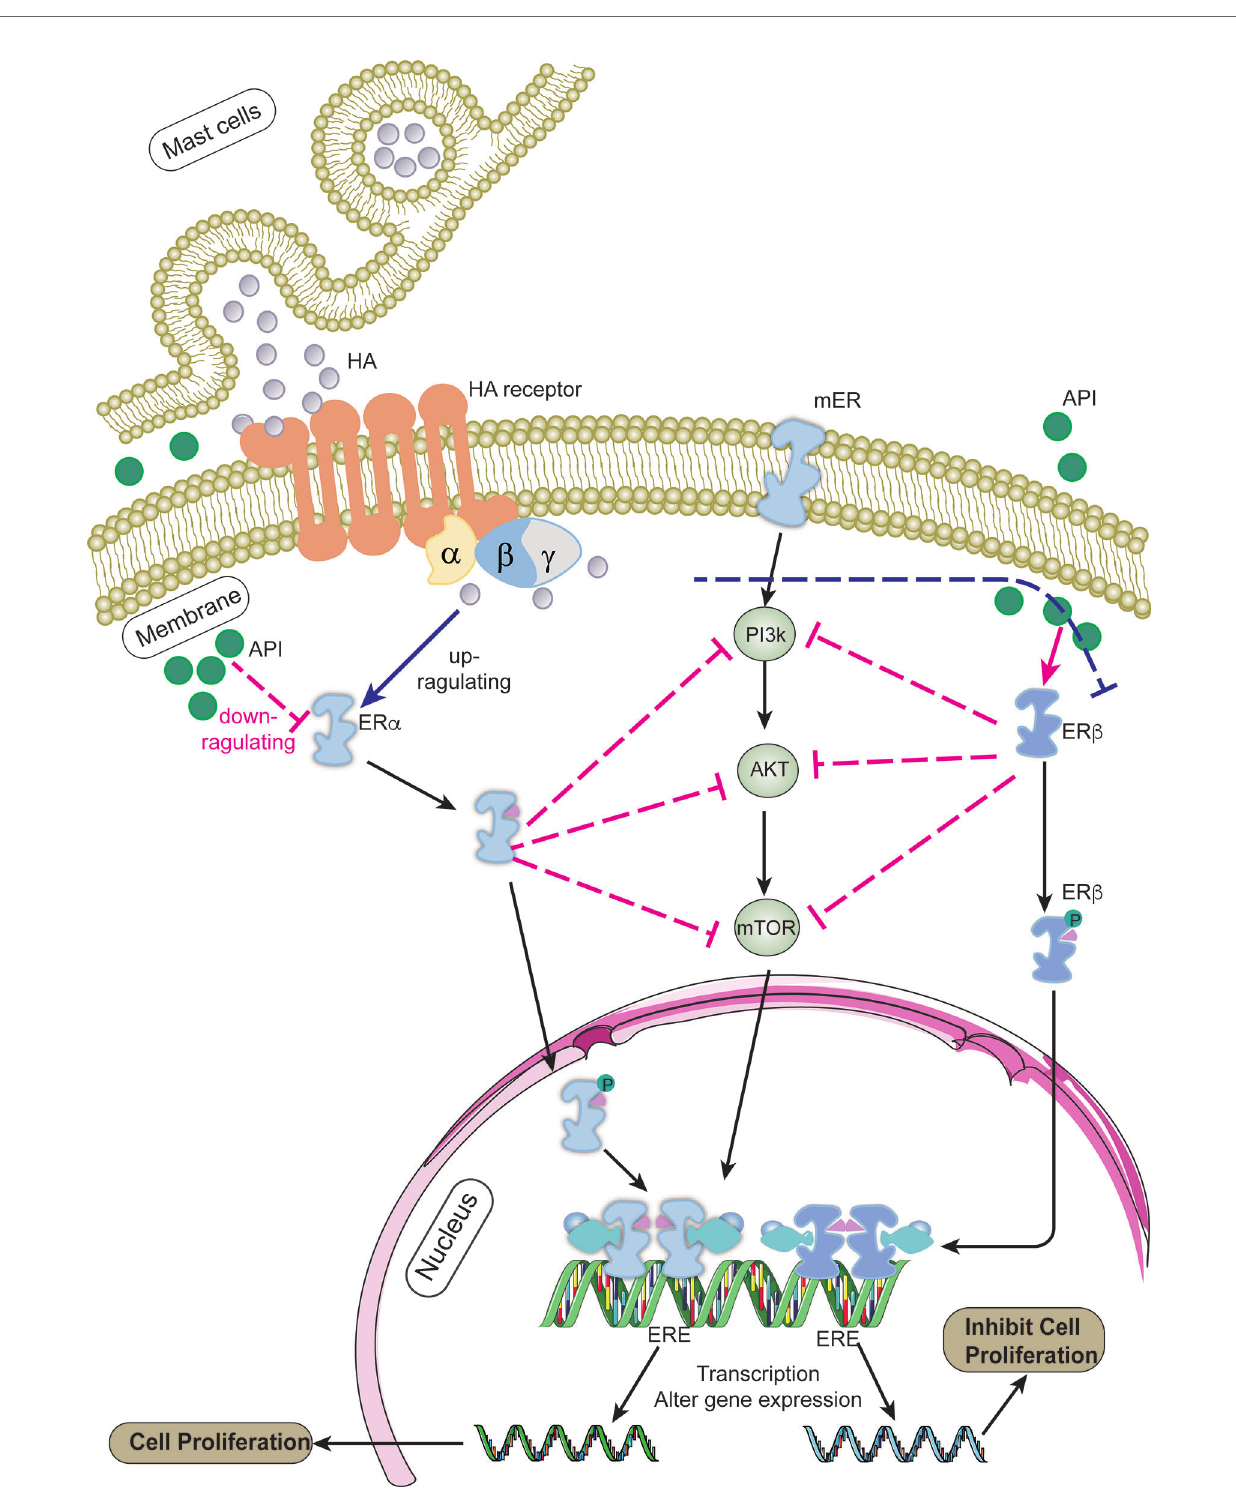
FIGURE 6 | The mechanism of apigenin for inhibiting the proliferation of ovarian cancer cells. After histamine binds to its receptors, it up-regulates the expression of ER a and down-regulates the expression ER b (blue line). ERs binds to the estrogen response element (ERE) sequence of the target gene promoter after dimerization (38), activating the transcription of downstream target gene (40, 41), such as cell cycle regulators (CCND1, c-Myc) and apoptosis-related proteins (BCL2, BCLXL), etc., which works on promoting cell proliferation and tumor development. Apigenin suppresses PI3K/AKT/mTOR signaling pathway by regulating the expression level of ER a /ER b (red line), thereby attenuates the development of ovarian cancer induced by